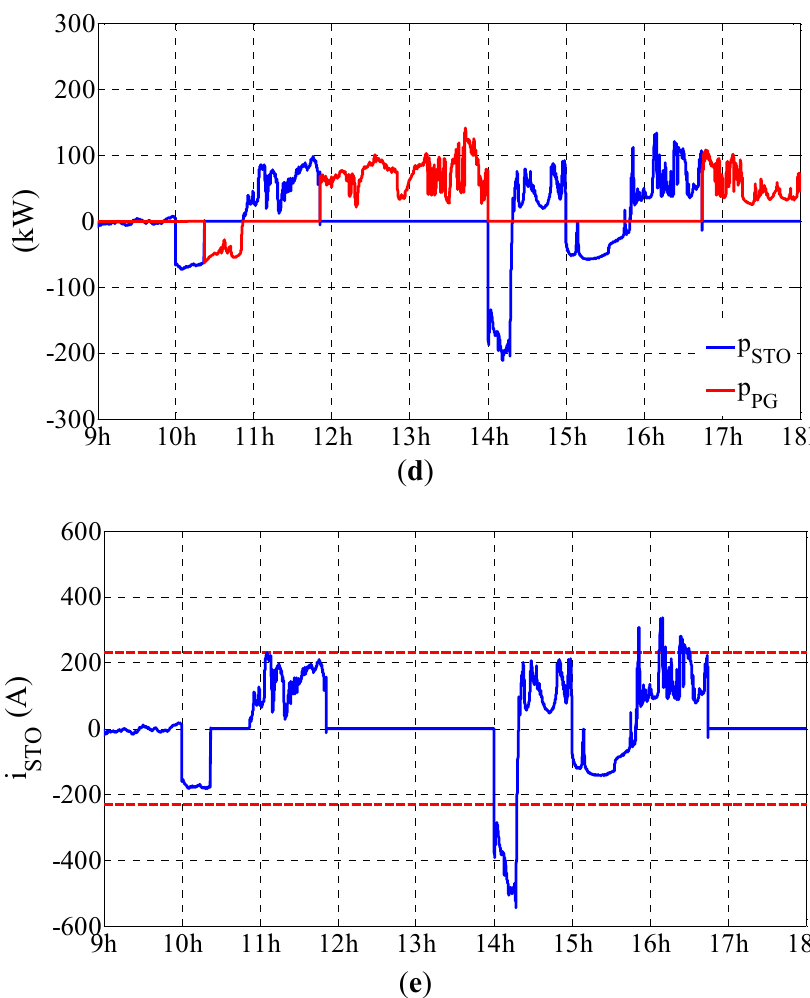
Figure 10. DC microgrid without storage current limitation case: ( a ) Solar irradiance and PV cell temperature; ( b ) Power evolutions of PVA, PEVs, and the difference between these two powers; ( c ) Storage SOC and distribution coefficient K ; ( d ) Power evolutions of storage and public grid; ( e ) Storage current